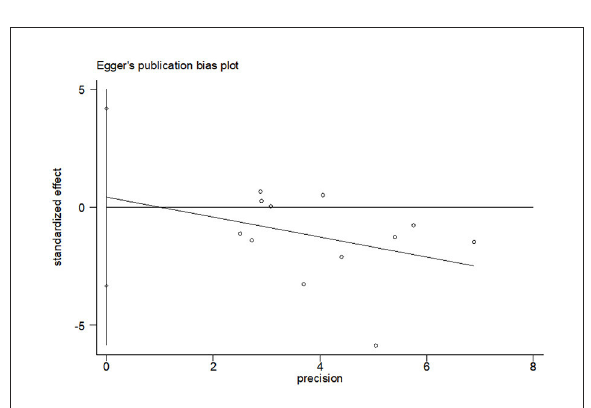
FIGURE8 Publication bias test of CBT effect on depression.